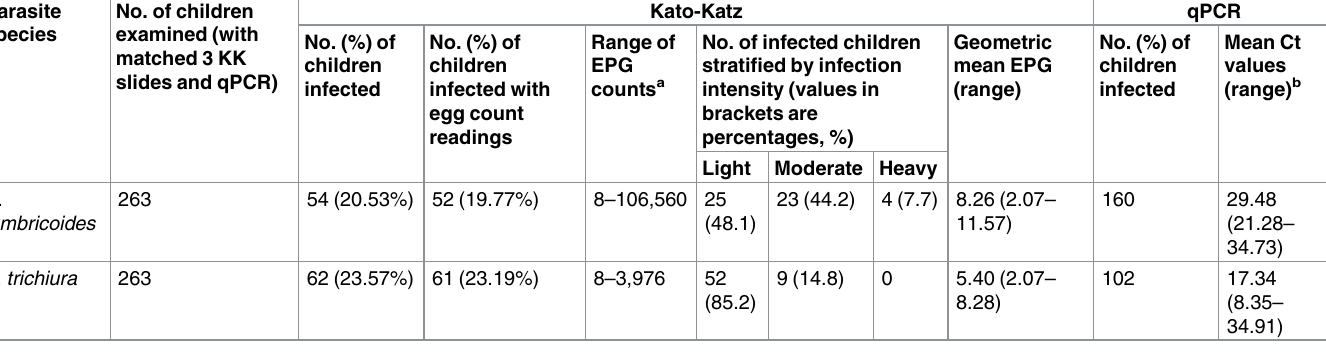
Table 4. Characteristics of STH infections among schoolchildren in selectedelementary schools in Laguna province, Philippines, as determined by the KK method and qPCR technique. Parasite No. of children species examined